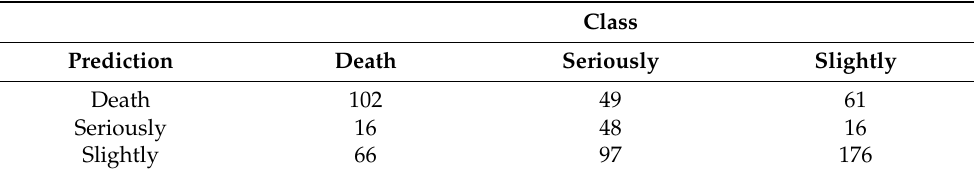
Table 2. Confusion matrix for the decision tree based on location of incident and